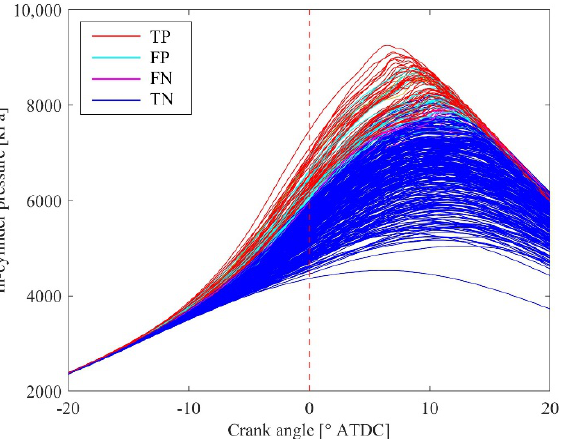
Figure 7. In-cylinder pressure color-coded by predicted class and actual class based on the results of the prediction using − 32° ATDC–0° ATDC.